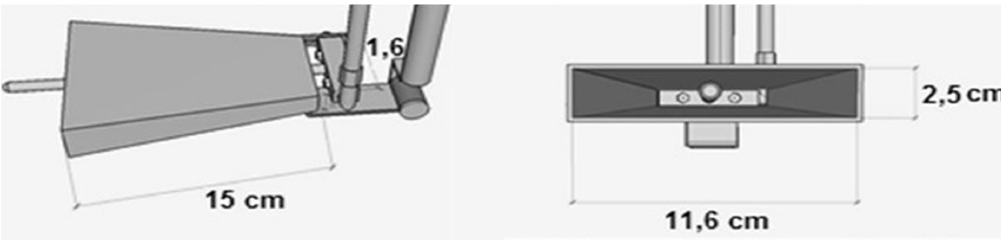
Figure 2. Burner, including specifications for the burner device used in the experiment.